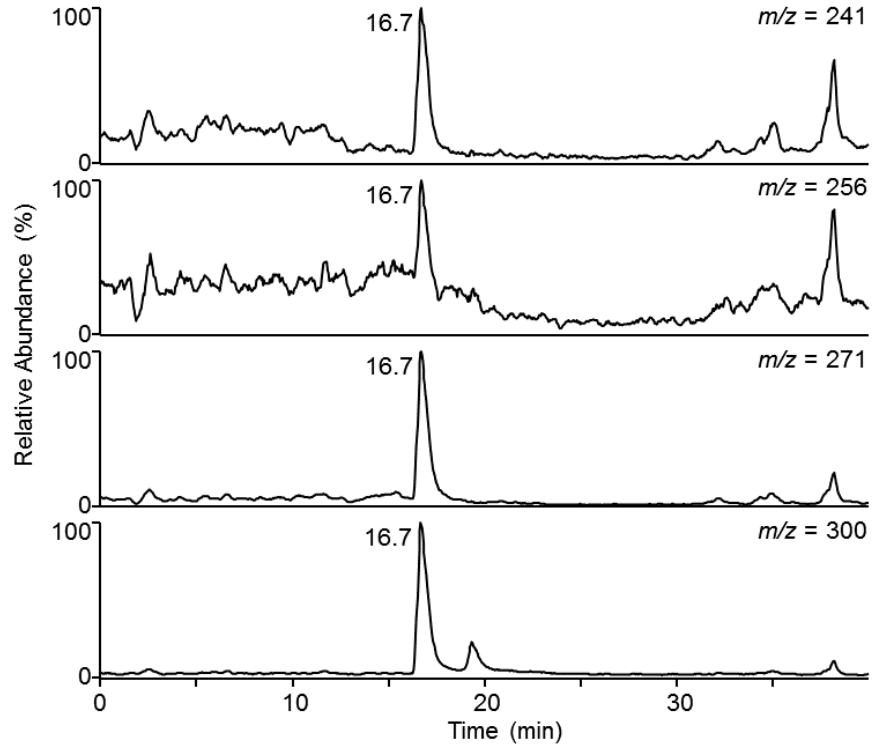
Figure 3. Chromatogram for elution of a 50 µg/mL solvent standard of 8- O -methylbostrycoidin.